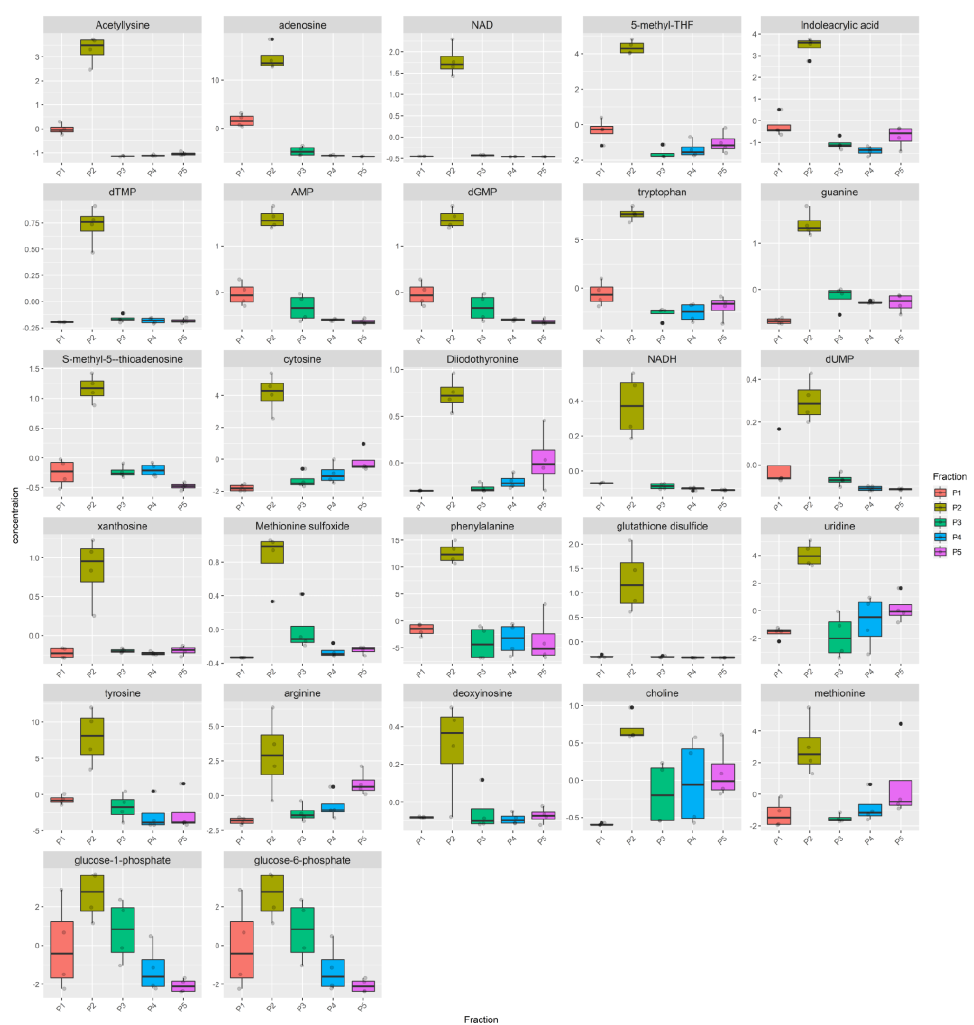
Figure 6. Metabolites enriched in the Goat P2 pool. For each fraction, four samples were analyzed. Raw data (quantitative relative ion count) were normalized using the Pareto Scaling normalization and analyzed using the ANOVA test. Only metabolites enriched in the Bovine P2 fraction are reported (FDR p < 0.05). The normalized concentration is reported for each metabolite in the P1, P2, P3, P4, P5 pools. The solid line represents the median, the box reports the interquartile range and the whiskers reports the minimum and maximum value of the distribution. Each sample is represented by a grey point, outliers are reported using a black point.